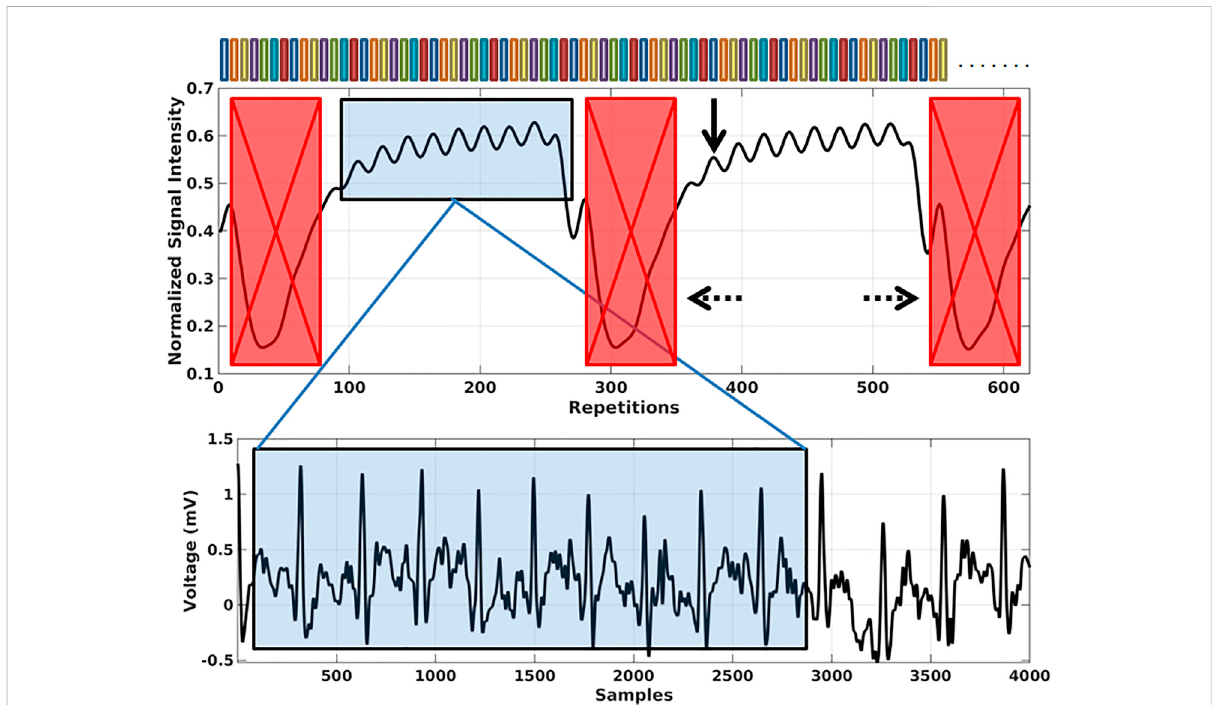
FIGURE 2 Representativeimageshowingthecardiacandrespiratorymotionmodulationsina fi lteredk 0 -navigatorsignal.Duringtheretrospectivesorting ofthemainSoS-4D- fl owradialspokes,theinspirationcyclesandtheircorrespondingradialspokeswerediscarded(dashedarrows).Thepeaksofthe cardiac modulations were considered as the onset of the heart cycles and the radial spokes were sorted accordingly (solid arrow). The color bars on top represent different radial